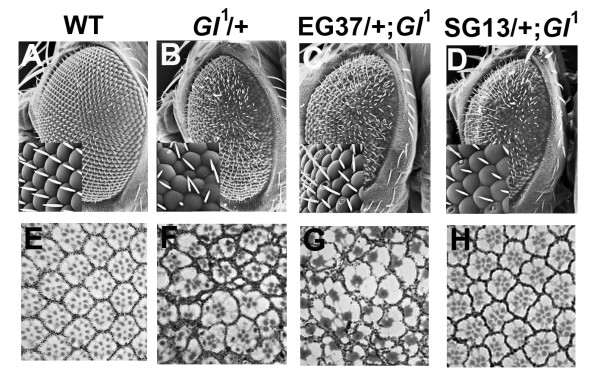
An enhancer and a suppressor interact with Gl1 in the adult eye. (A-D) Scanning electron micrographs of adult eyes. (A) Wild type. (B) Gl1/+, (C) EG37/+;Gl1/+, both exhibiting a roughened, smaller eye. (D) SG13/+;Gl1/+ showing a slight amelioration of the Gl1 phenotype. Insets are higher magnifications. (E-H) Tangential sections of adult eyes. (E) Wild type showing the regular pattern of ommatidial assembly and the stereotyped trapezoidal pattern of the rhabdomeres of the photoreceptor cells (R1-R7). (F) Gl1/+ eye showing disordered and irregular shaped ommatidia often with aberrant numbers of rhabdomeres. (G) The disorganization is exacerbated in the presence of EG37/+ with the rhabomeres often fused. (H) In the presence of SG13/+ the ommatidia show a more ordered, regular, pattern with each ommatidia often having the correct array of rhabdomeres (compare with E and G).